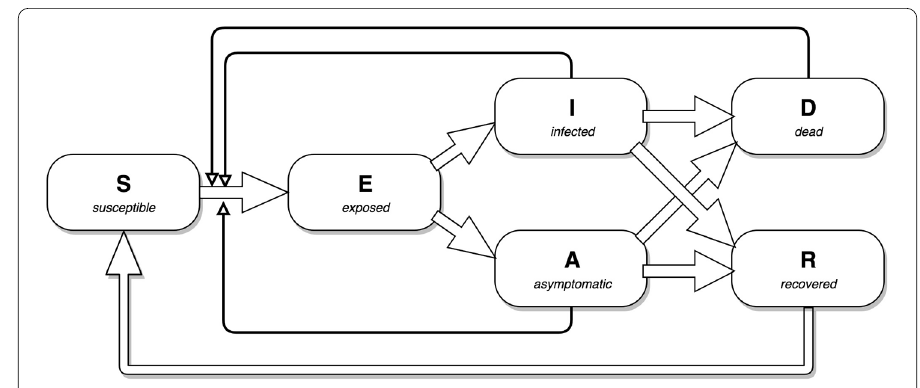
Figure 1 Flow diagram of the control-free model transitions